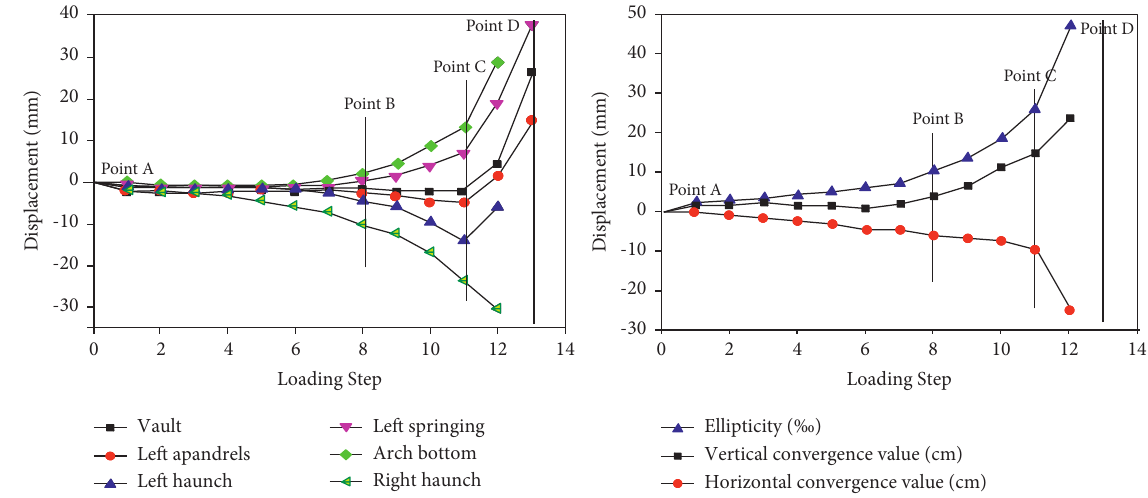
Figure 4: Force-displacement curves at each characteristic point [63]. Table 1: Summary of relevant literature on precast